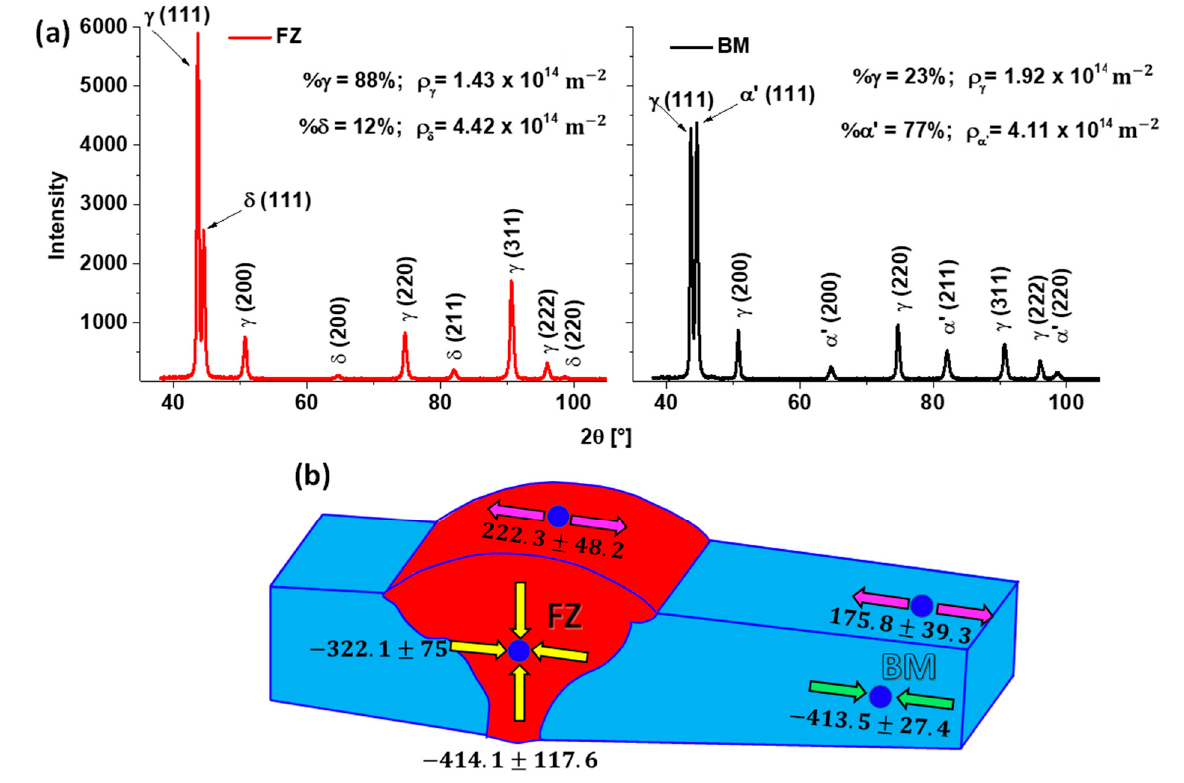
Figure 11. ( a ) X-ray diffraction patterns from the FZ and the BM zones and ( b ) residual stresses in the weld seam (values are in MPa).